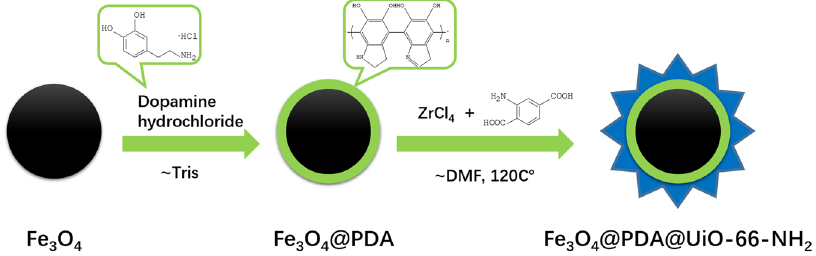
Figure 6. The Synthetic Route for Fe 3 O 4 @PDA@UiO-66-NH 2